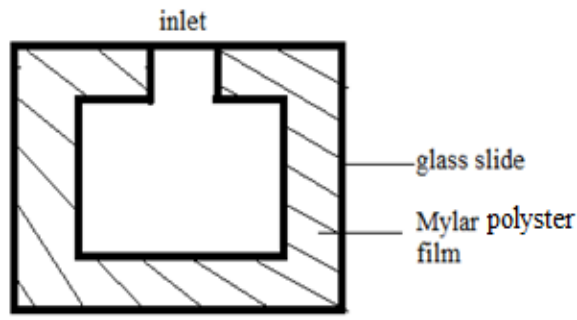
Figure 2. Cell for LC–solid interface sensing.